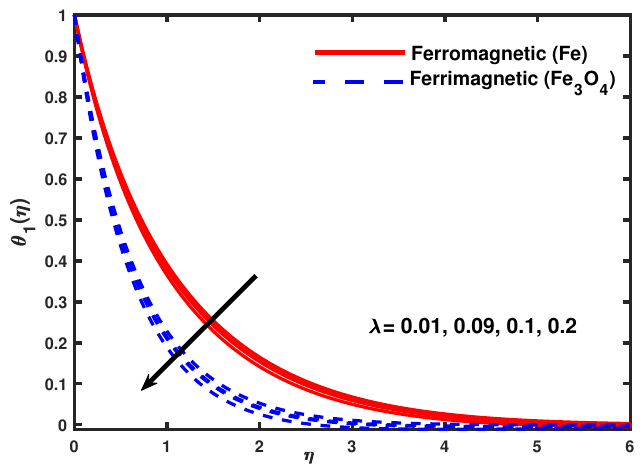
Figure 15. Impact of magnetic nano-particles and viscous dissipation ( λ ) on the temperature profile θ 1 ( η ) .